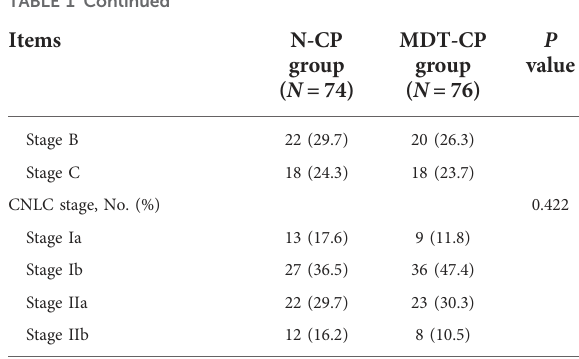
TABLE 1 Clinical